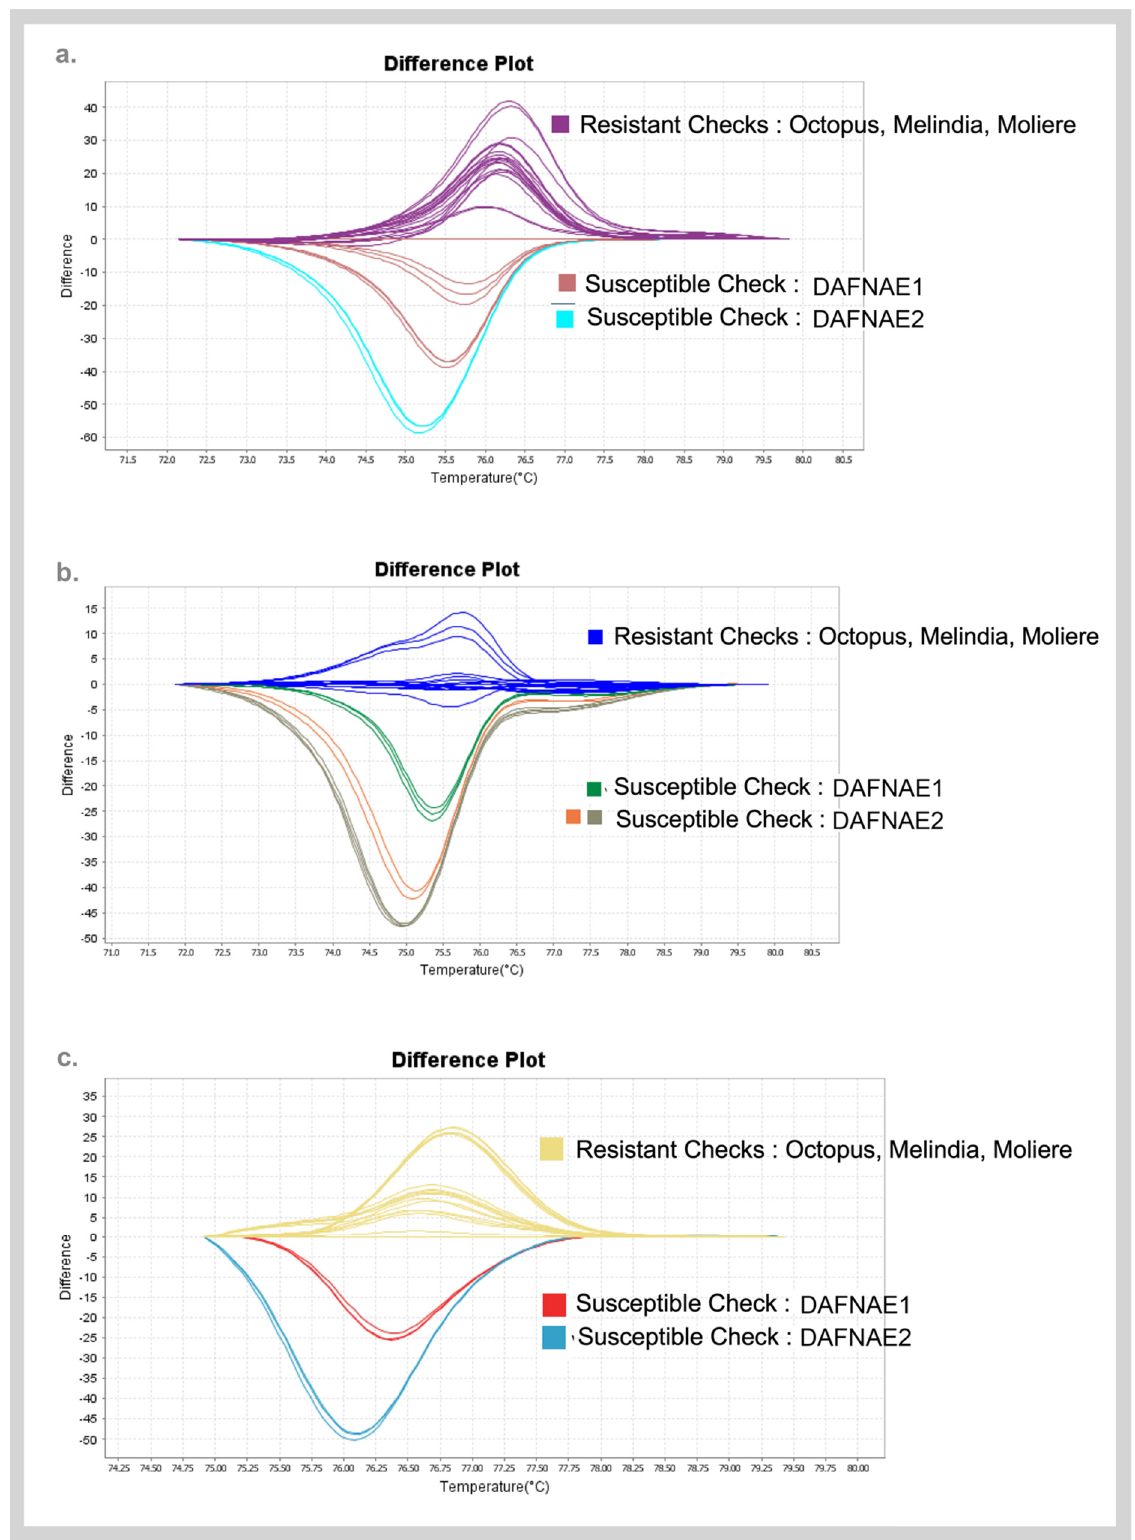
Figure 4. Melt curve profiles of best targets ( a ) SNP94 (Chr6), ( b ) SNP23 (Chr9), and ( c ) RsBv1 (Chr6) from high ‐ resolution melting analyses discriminating the resistant and susceptible checks.